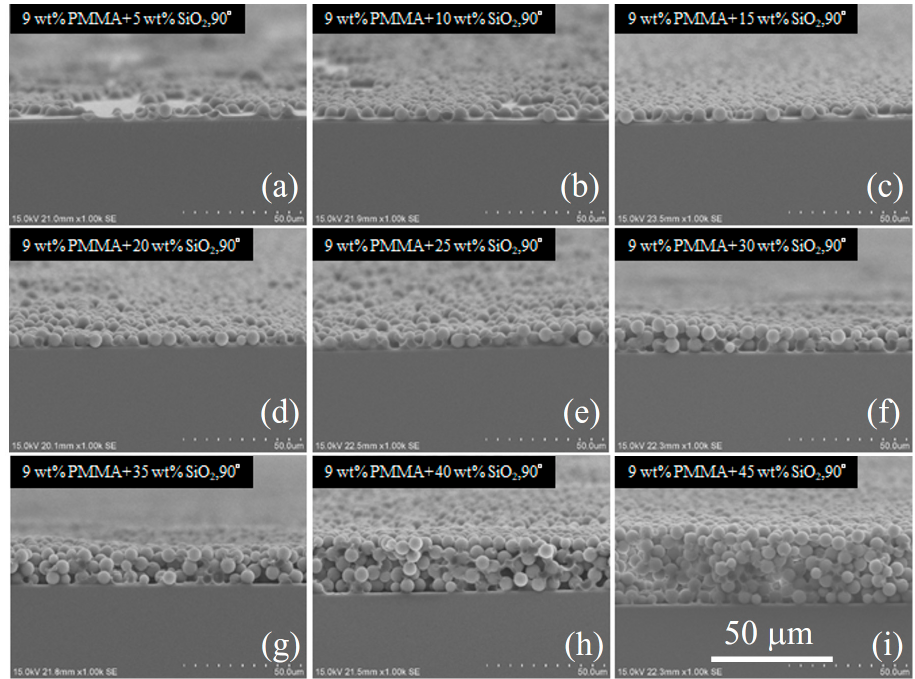
Figure 2. Side-view of the SEM photograph of the fabricated SiO 2 –PMMA composite film with a total area of 15 mm × 15 mm. ( a – i ) indicate the weight percent concentration of SiO 2 particles gradually increased from 5 wt% to 45 wt%.